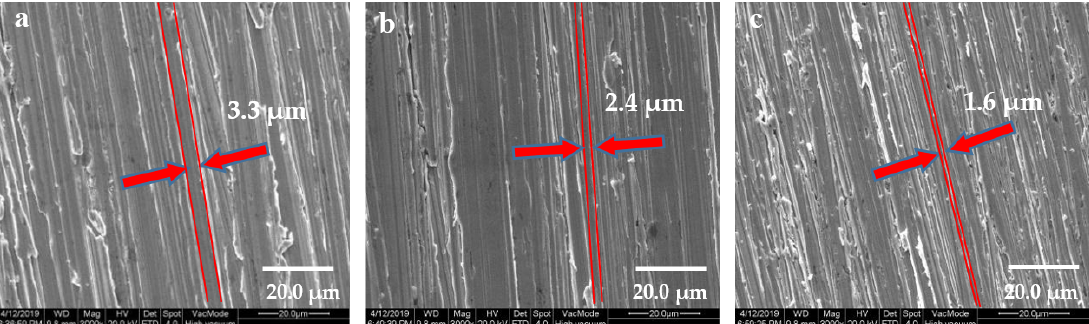
Figure 1. Copper sheets morphology under SEM. ( a ) Ground with 320 grit SiC sandpaper; ( b ) ground with 800 grit SiC sandpaper; ( c ) ground with 1500 grit SiC sandpaper.